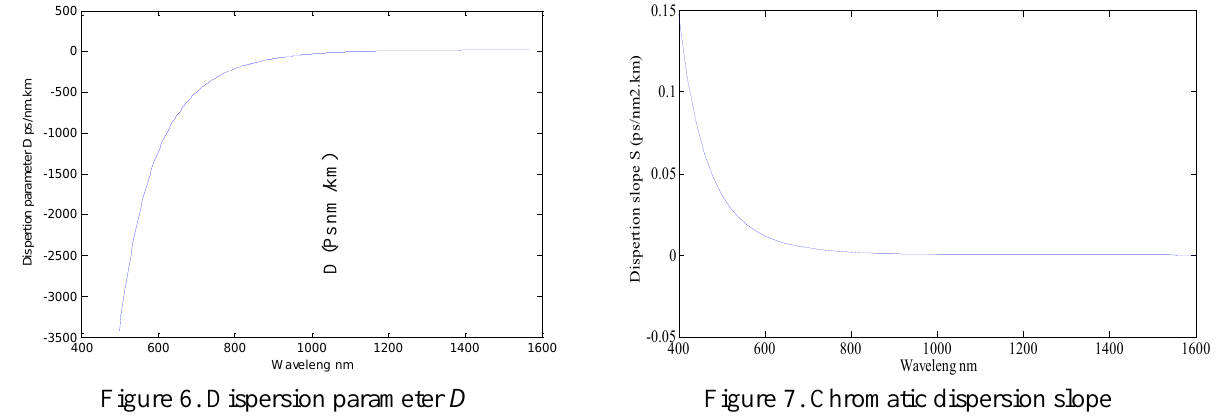
Figure 6. Dispersion parameter D Figure 7. Chromatic dispersion